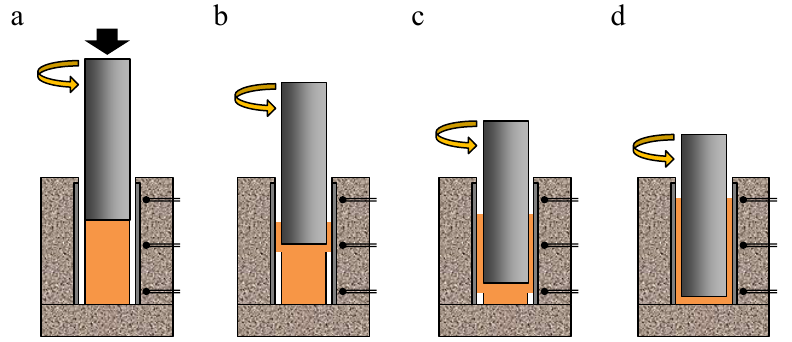
Figure 3. Schematic of deformation images of precursor during friction welding.